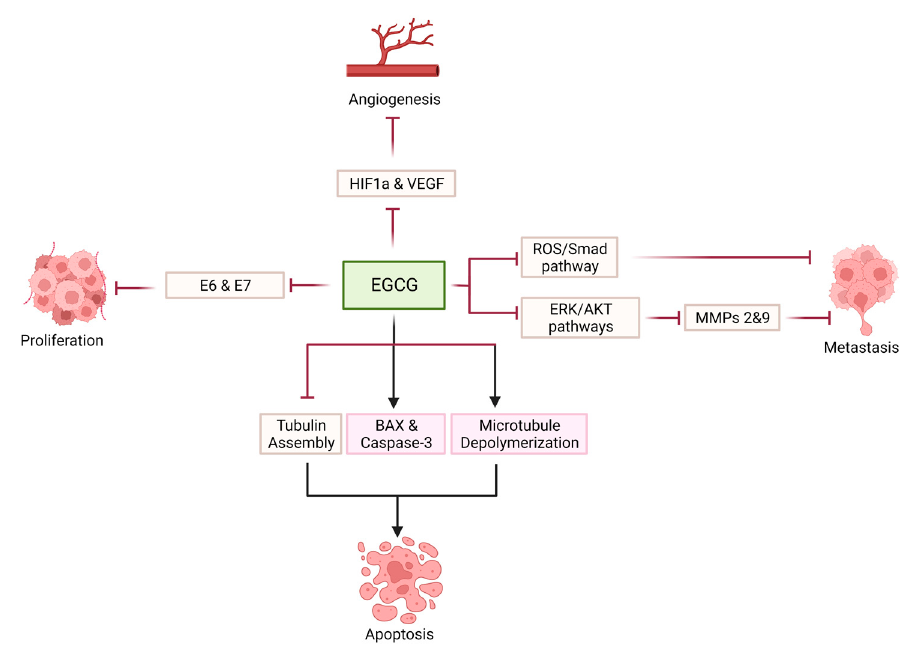
Figure 6. Effect of EGCG on cervical cancer cells.